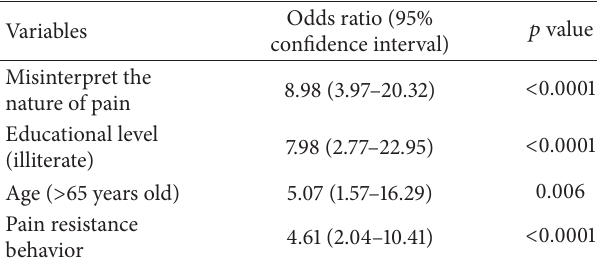
Table 4: Logisticregressionforfactors influencing prehospital delay for patients with